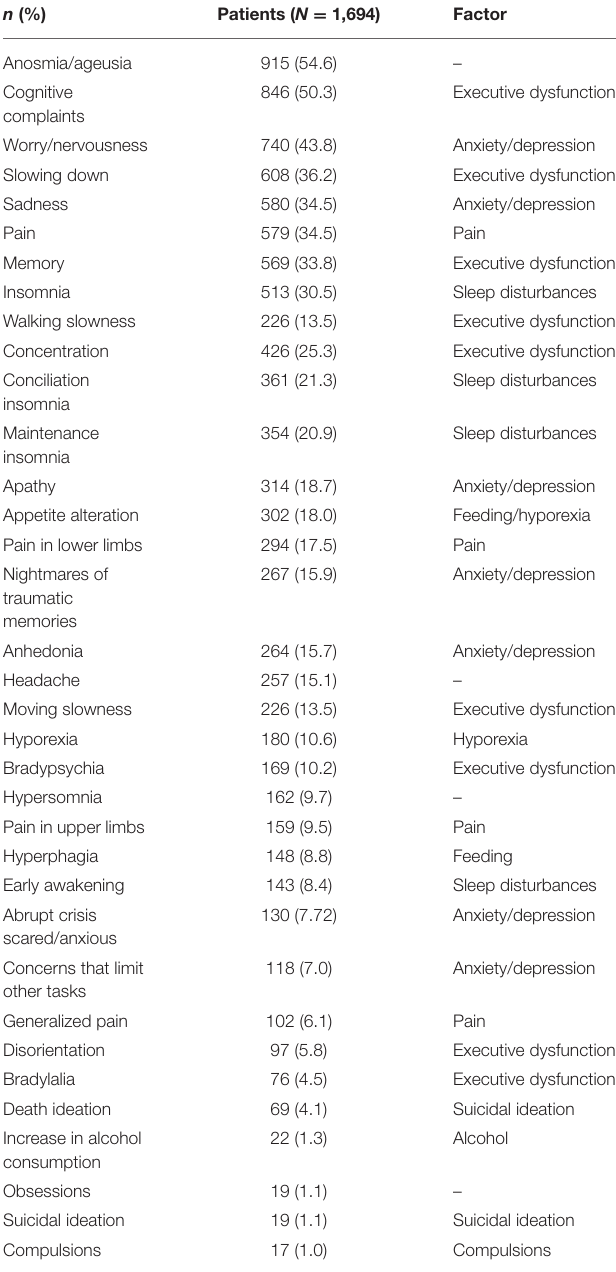
TABLE 2 | Frequency of symptoms identified in patients and aggrupation into